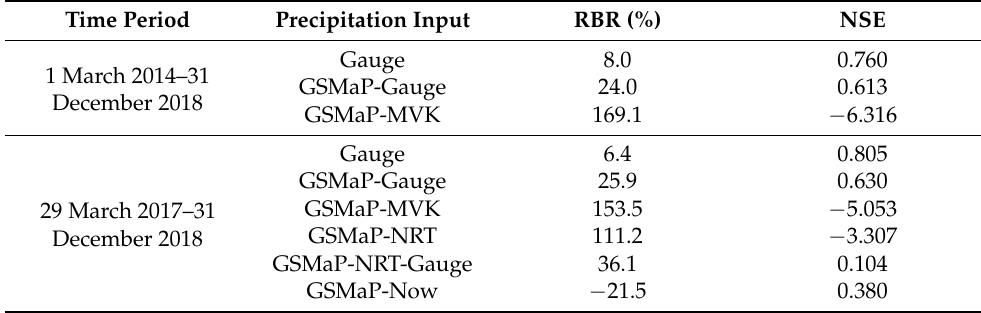
Figure 8. Observed and simulated daily hydrographs at the Tangnaihai hydrological station using the rain-gauge-, GSMaP-MVK-, and GSMaP-Gauge-based precipitation data inputs in the period of 1 March 2014–31 December 2018 (Q_obs denotes the observed discharge; Q_Gauge represents the simulated discharge using the rain-gauge-based precipitation data; Q_GSMaP-MVK and Q_GSMaP-Gauge are the simulated streamflow using GSMaP-MVK and GSMaP-Gauge SPPs, respectively; P_Gauge denotes the rain-gauge-based basin-averaged precipitation; and P_GSMaP-MVK and P_GSMaP- Gauge represent the GSMaP-MVK- and GSMaP-Gauge-based basin-averaged precipitation, respectively). Table 3. Statistical indices of daily discharge simulations at the Tangnaihai hydrological station using the rain-gauge-based precipitation data and the five GSMaP